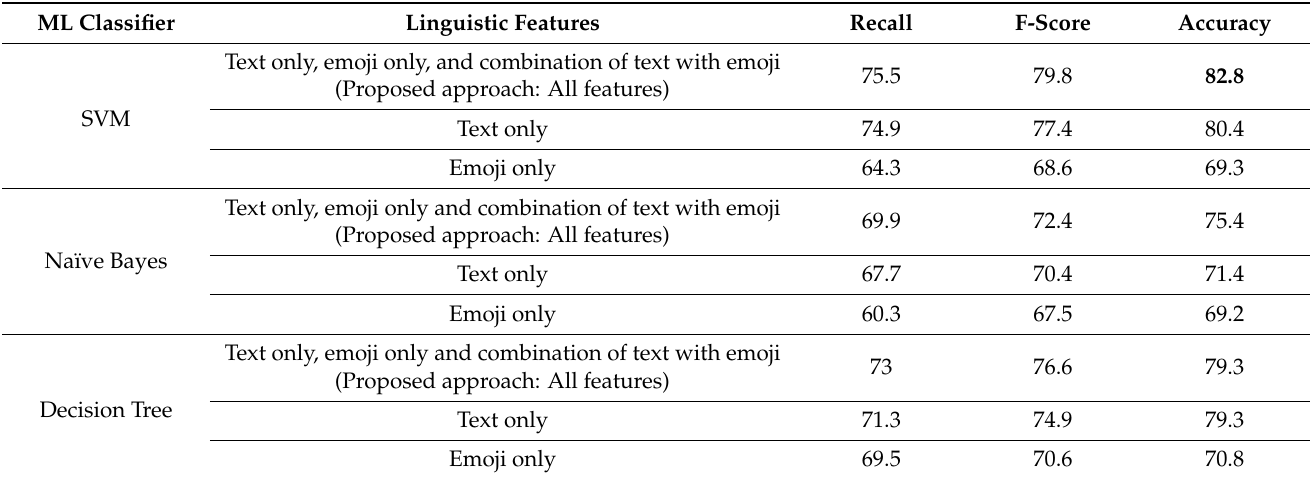
Table 8. The experiment results of various ML classifiers for different combinations of linguistic features.